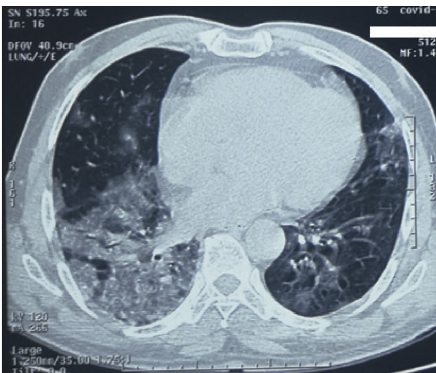
Figure 1: Chest CT scan in the axial section of the mediastinal window showing ground glass images with an asymmetrical pe- ripheral arrangement under the pleural layer, producing a crazy- paving appearance characteristic of typical COVID-19 pneumonia.